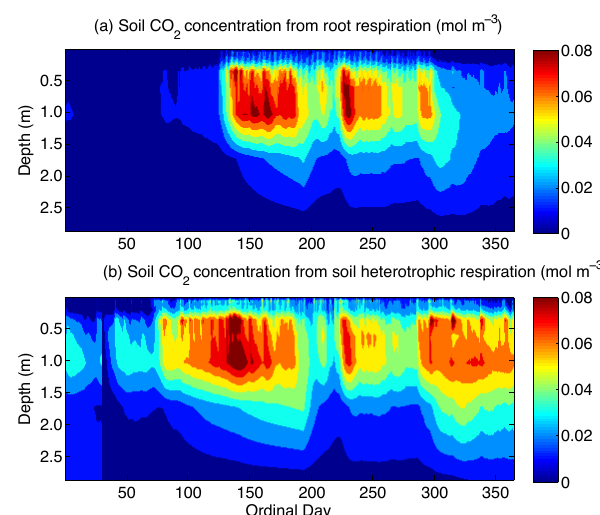
Figure 10. Simulated seasonal cycle of soil CO 2 concentrations contributed from (a) 2 Fig. 10. Simulated seasonal cycle of soil CO 2 concentrations con- autotrophic root respiration and (b) soil heterotrophic respiration. 3 tributed from (a) autotrophic root respiration and (b) soil het- erotrophic